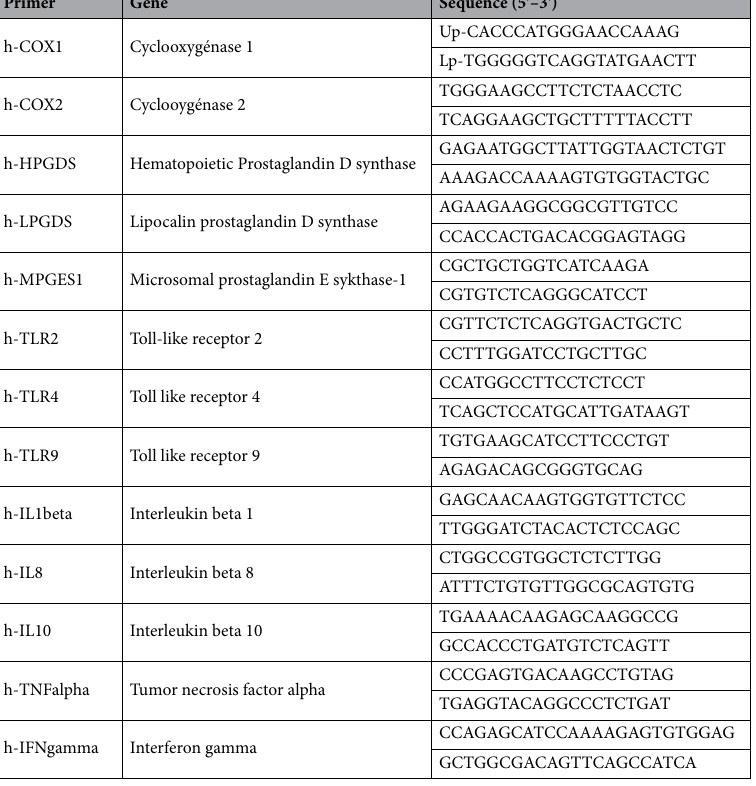
Table 3. Primers for qPCR